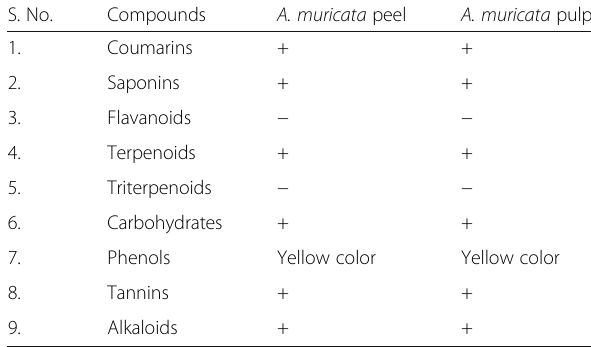
Table 3 The various phyto chemicals present in the plant extract S. No.